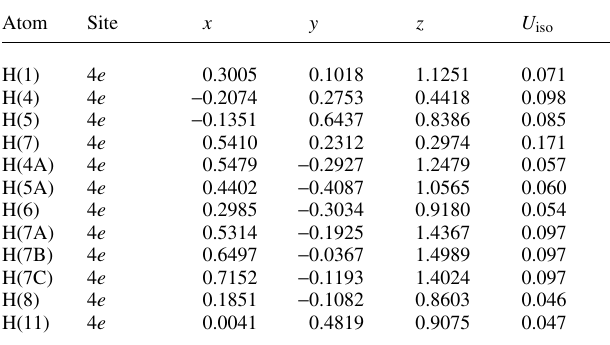
Table 2. Atomic coordinates and displacement parameters (in Å 2 )